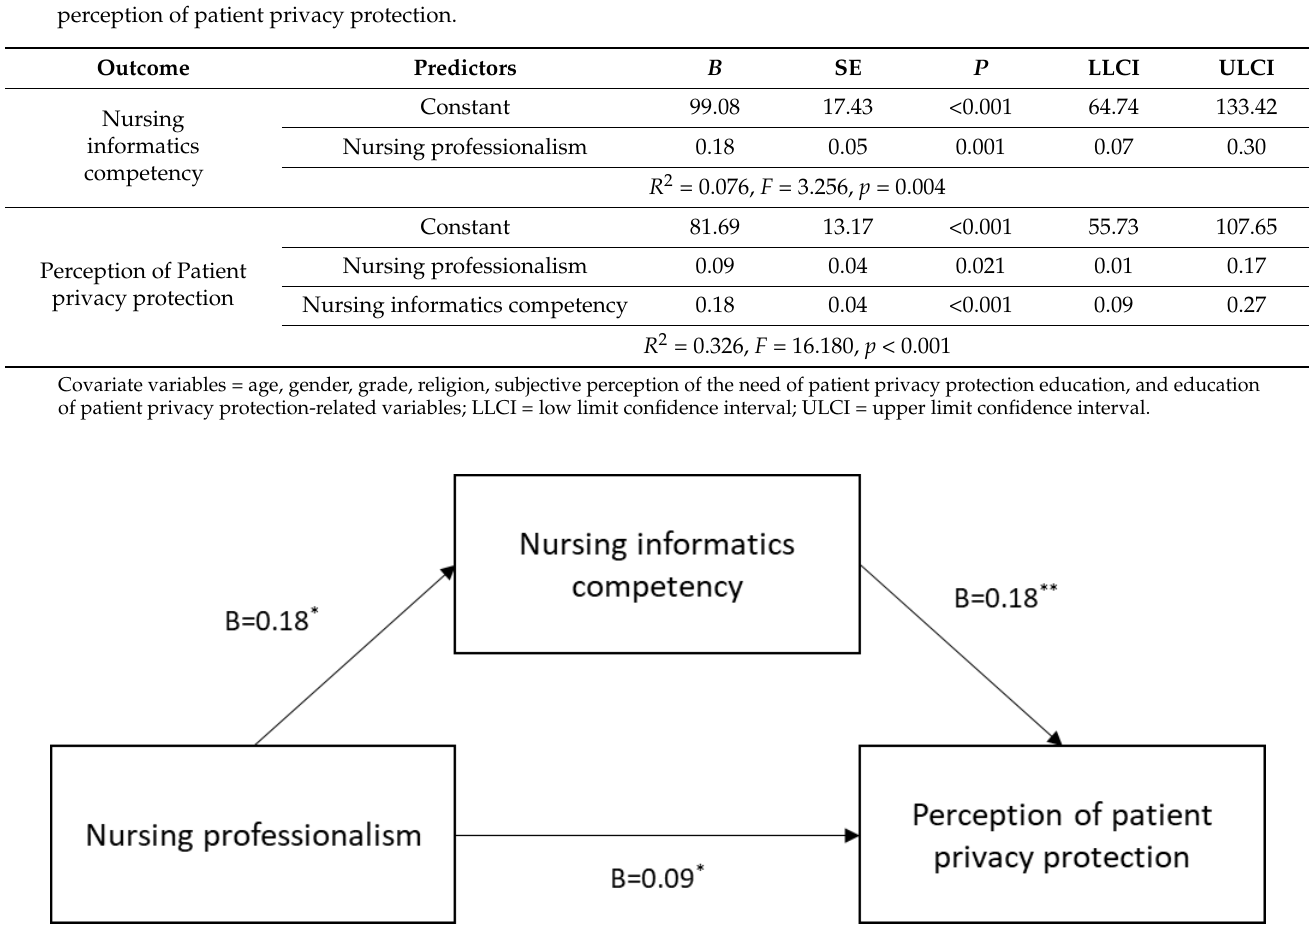
Figure 1. Mediating effect of nursing informatics competency on the relationship between nursing professionalism and perception of patient privacy protection (* p < 0.05, ** p < 0.001) .